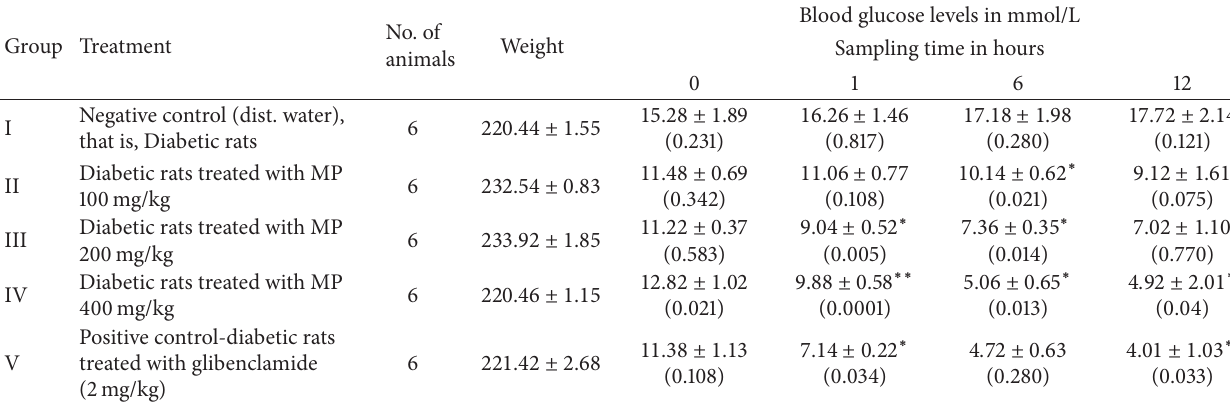
Table 1: The effect of MP extract on the fasting blood glucose levels of test rats. Group